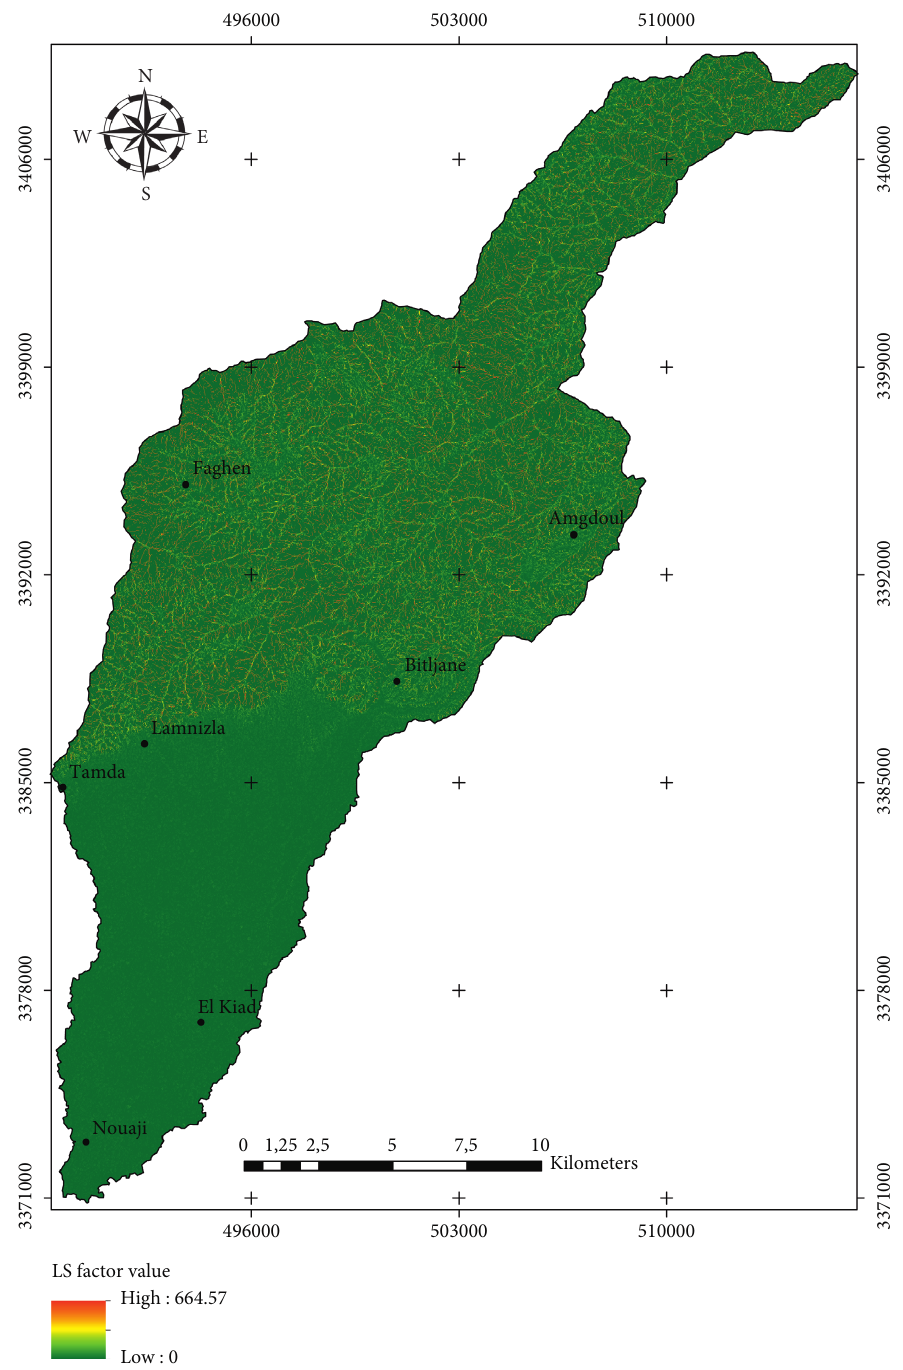
Figure 6: Spatial distribution of topographic factor (LS) at Beni Mohand River